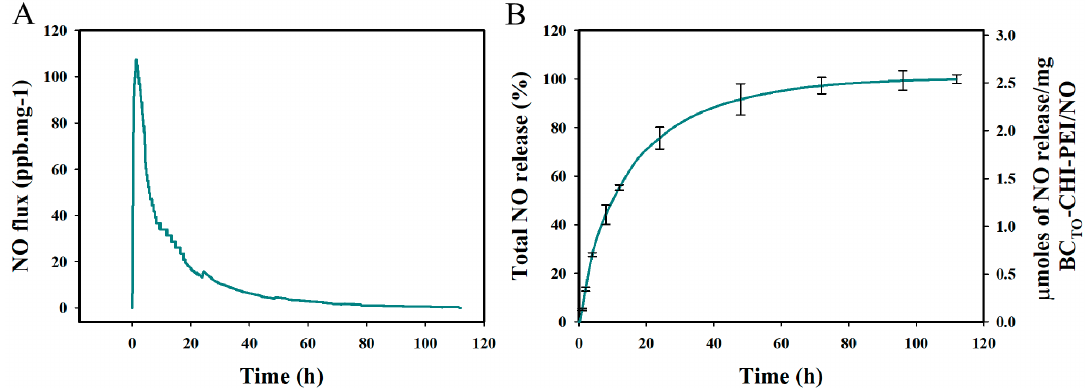
Figure 5. ( A ) Real-time NO release of BC TO -CHI-PEI/NO hydrogels. ( B ) Percentage of the total NO released, and amount of NO released over time in phosphate-buffered saline (PBS; pH 7.4, 37 °C), measured using a Sievers 280i chemiluminescence NO analyzer. Data are presented as the mean ± standard deviation; n = 3.